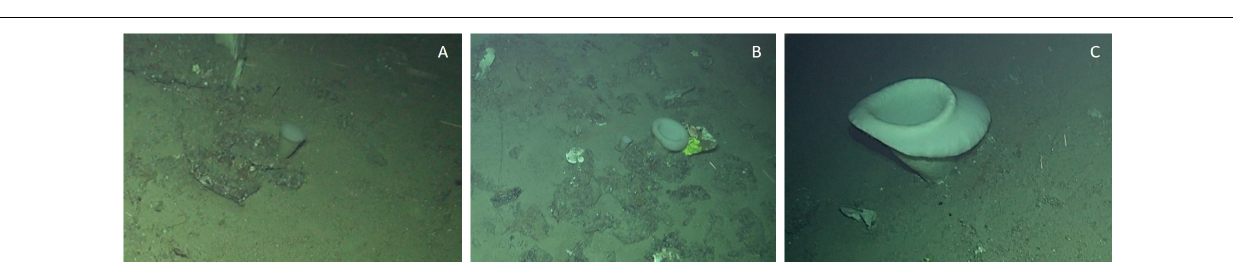
FIGURE 10 | Specimens of A. setubalense with different sizes. Different degree of flounce development can be observed. (A,B) Two small specimens without a flounce. (B) Medium size of A. setubalense where the development of the flounce can be seen. (C) Large size specimen with a notable